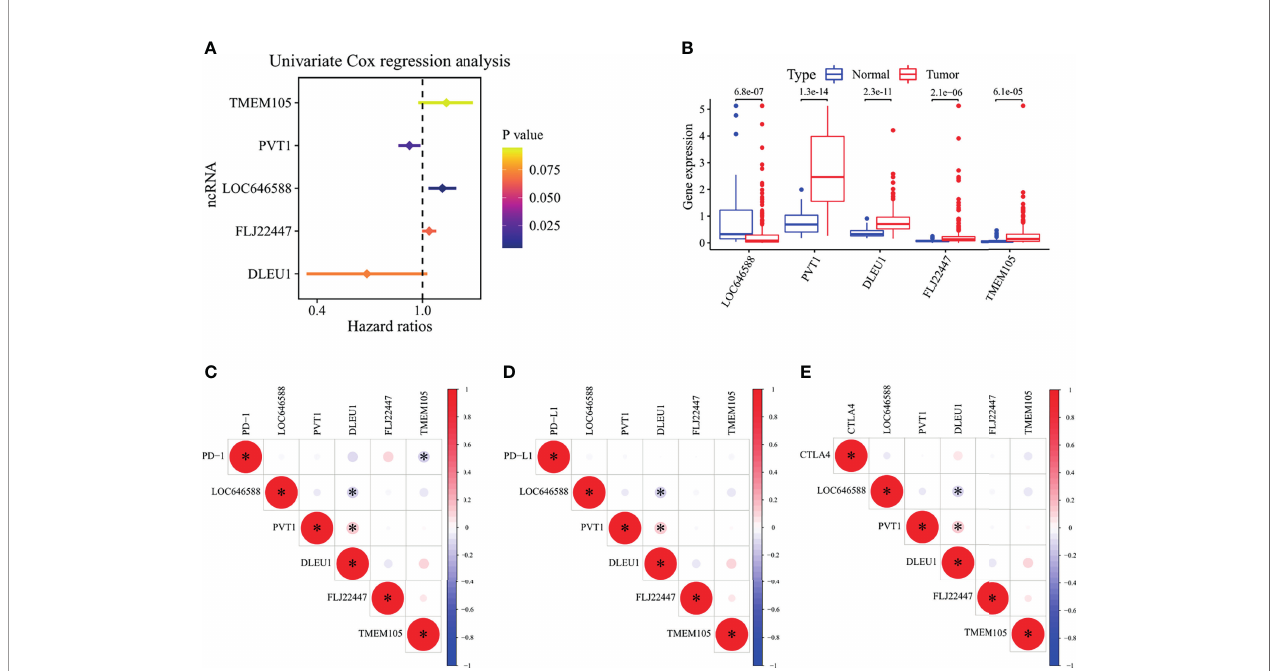
FIGURE 1 | Analysis of univariate Cox regression, differential ncRNA expression pro fi les, and RNA correlation analysis in The Cancer Genome Atlas — stomach adenocarcinoma cohort. (A) Forest plot showing the P -values and hazard ratios of fi ve ferroptosis-related ncRNAs from univariate Cox regression analysis. A hazard ratio greater than 1 indicates that the ncRNA is a risk factor for the survival of gastric adenocarcinoma patients, and a hazard ratio less than 1 indicates that the ncRNA is a protective factor for the survival of gastric adenocarcinoma patients. (B) Box plot for ferroptosis-related ncRNAs generated by a comparison of the normal group versus the tumor group. The value shown in the fi gure is the P -value. (C – E) Correlation among three immune checkpoint genes (PD-1, PD-L1, and CTLA4) and ferroptosis-related ncRNAs. Red indicates a positive correlation, blue indicates a negative correlation, and an asterisk indicates a signi fi cant correlation between the two RNAs. STAD, stomach adenocarcinoma. *P < 0.05.